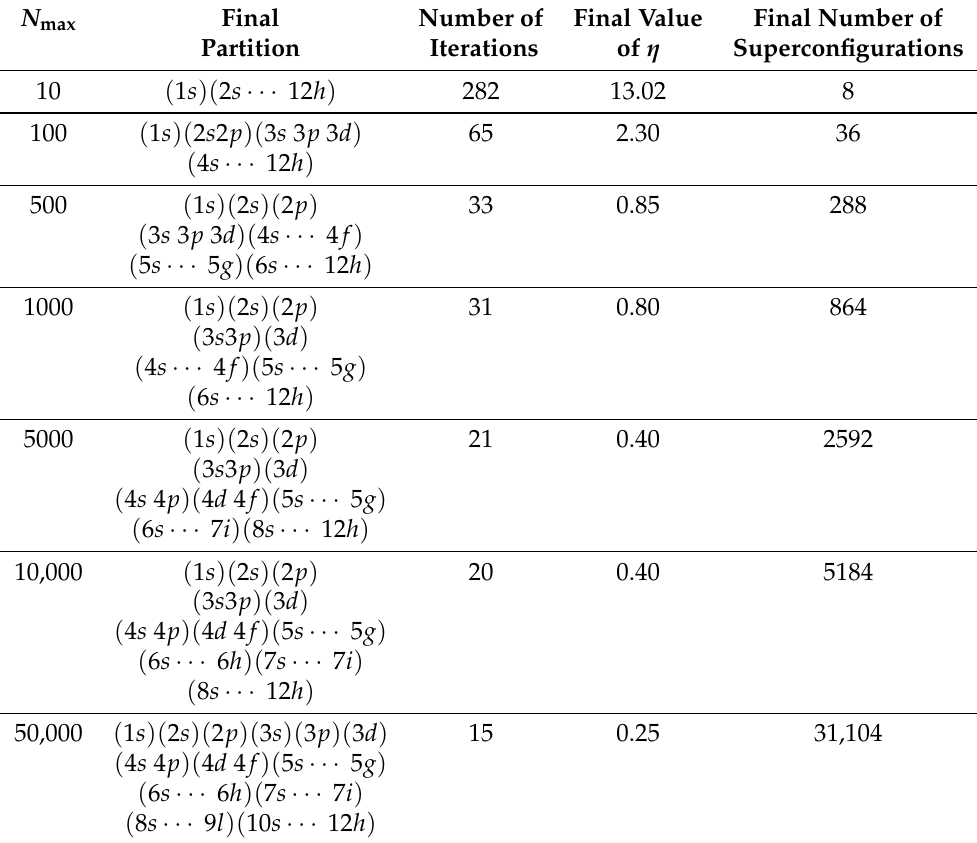
Table 1. Final supershell partitions, number of iterations, final value of η and number of effective superconfigurations found for different maximum numbers N max , in the case where our initial value of η has its default value 0.05. The initial number of superconfigurations, obtained with the supershell partition of Equation (57), is